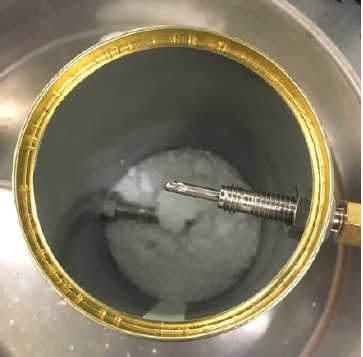
Figure 5. The cup ignition test with two thermocouples.